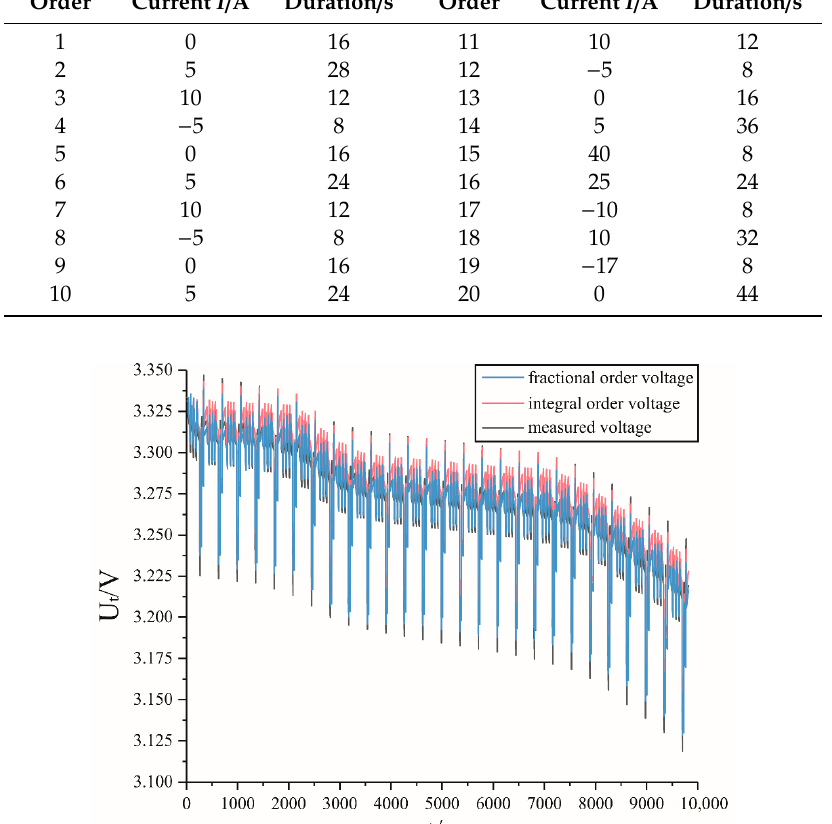
Table 2. Current and duration of dynamic stress test (DST).